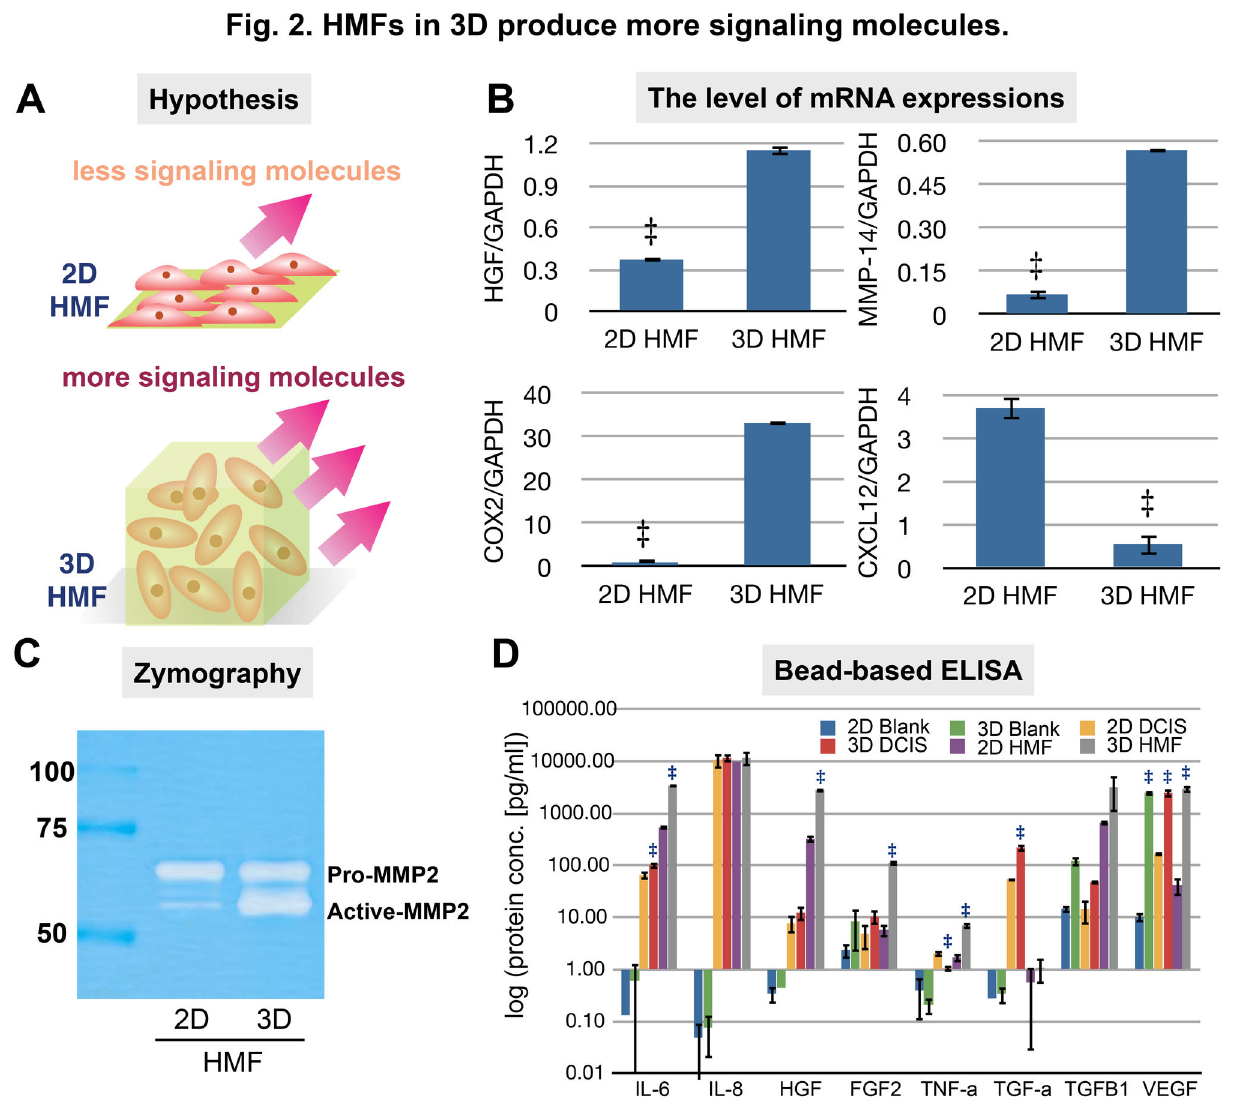
Figure 2. HMFs in 3D produce more signaling molecules. (A) Conceptual illustration showing HMFs in 3D produce more signaling molecules. (B) Bar graphs showing the mRNA expressions of HGF, MMP14, COX2, and CXCL12 in HMFs cultured in 2D and 3D conditions. ‡ represents a p value of less than 0.05. (C) Zymography showing the presence of increased active MMP2 in the 3D conditioned medium of HMFs. (D) Bead-based ELISA showing the concentrations of target proteins in conditioned media collected from 3D and 2D cultures of HMFs and MCF-DCIS